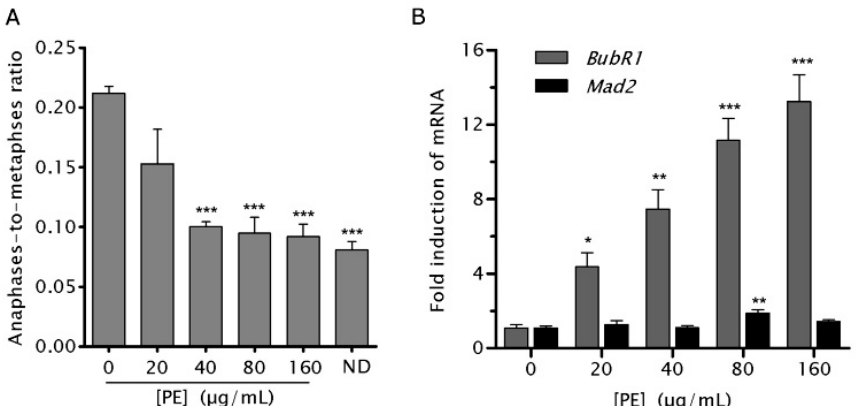
Figure 5. P. emblica (PE) treatment activated the spindle assembly checkpoint (SAC) and upregulated the expression of budding uninhibited by benzimidazoles related 1 ( BubR1 ) in NCM460 cells. ( A ) NCM460 cells were treated with indicated doses of PE or 300 ng/mL nocodozale (ND, positive control) for 4 h followed by recovery for 1 h before cells were harvested for determining anaphase-to-metaphase ratio (AMR), an estimated measurement of SAC activity. AMR was obtained by dividing the total number of anaphase cells by the total number of metaphase cells counted for each PE concentration; ( B ) NCM460 cells were treated with indicated doses of PE for 72 h, BubR1 (gray bars) and mitotic arrest deficient 2 ( Mad2 ; black bars) mRNA levels were measured by real-time quantitative polymerase chain reaction (PCR) after mRNA extraction and reserve transcription. Samples for each experimental group were run in triplicates and normalized to glyceraldehyde-3-phosphate dehydrogenase ( GAPDH ) mRNA levels. Results are expressed as fold increase in treated cells vs. untreated control. Values represent the means ± SEM of the fold induction taken from three independent experiments. * p < 0.05; ** p < 0.01; *** p < 0.001 vs. untreated control.